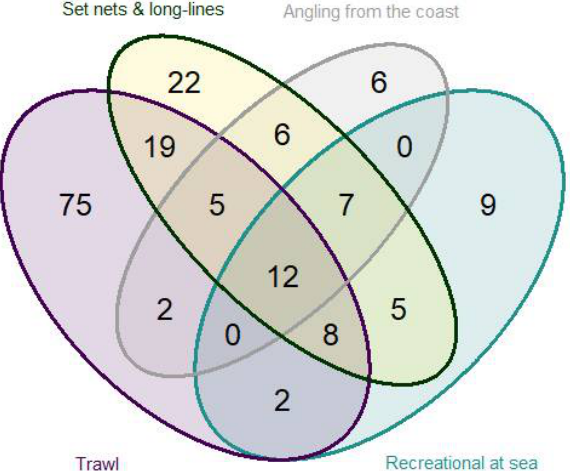
Figure 3. Venn diagram of the number of species caught in the different fishing methods, and the species common to different methods.